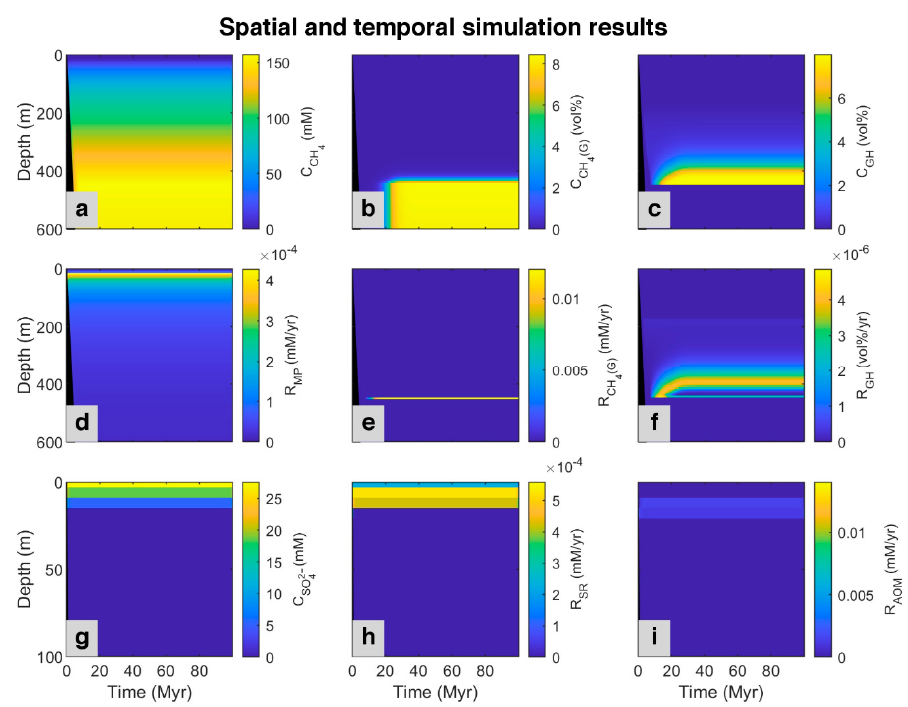
Figure A1. Spatial and temporal results of the model for the simulated ODP site 997 [49]. First row: Concentration profile of ( a ) Dissolved methane (CH 4 ); ( b ) Methane in the gas phase (CH 4 (g)); ( c ) Methane in hydrate phase (GH). Second row: Simulated rate of ( d ) Methanogenesis (MP); ( e ) Free gas formation (CH 4 (G)), and ( f ) Gas hydrate formation (GH). Last row presented in shorter depth (to magnify the rate changes): ( g ) Concentration profile of sulfate (SO 42 − ); simulated rate of ( h ) Sulfate reduction (SR), and ( i ) Anaerobic oxidation of methane (AOM). The black area refers to the place where no sedimentation occurred.